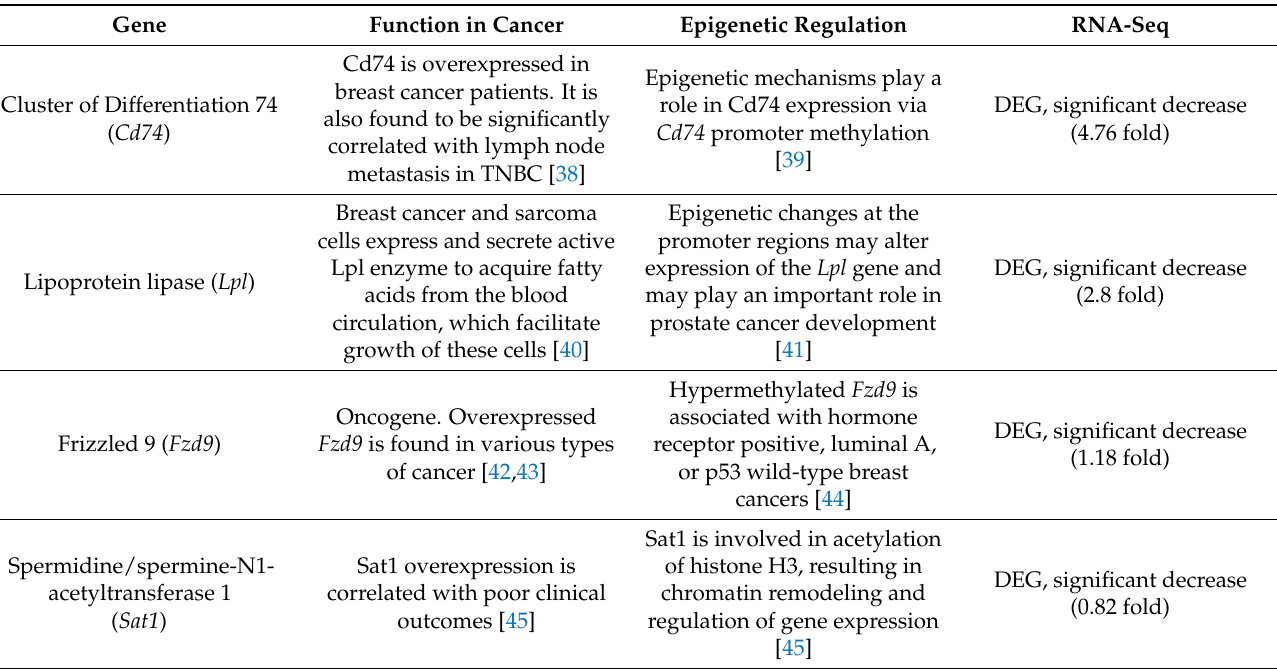
Table 2. Identified key genes showed significantly differential expression in response to GE treatment, and their role in epigenetic mechanisms and